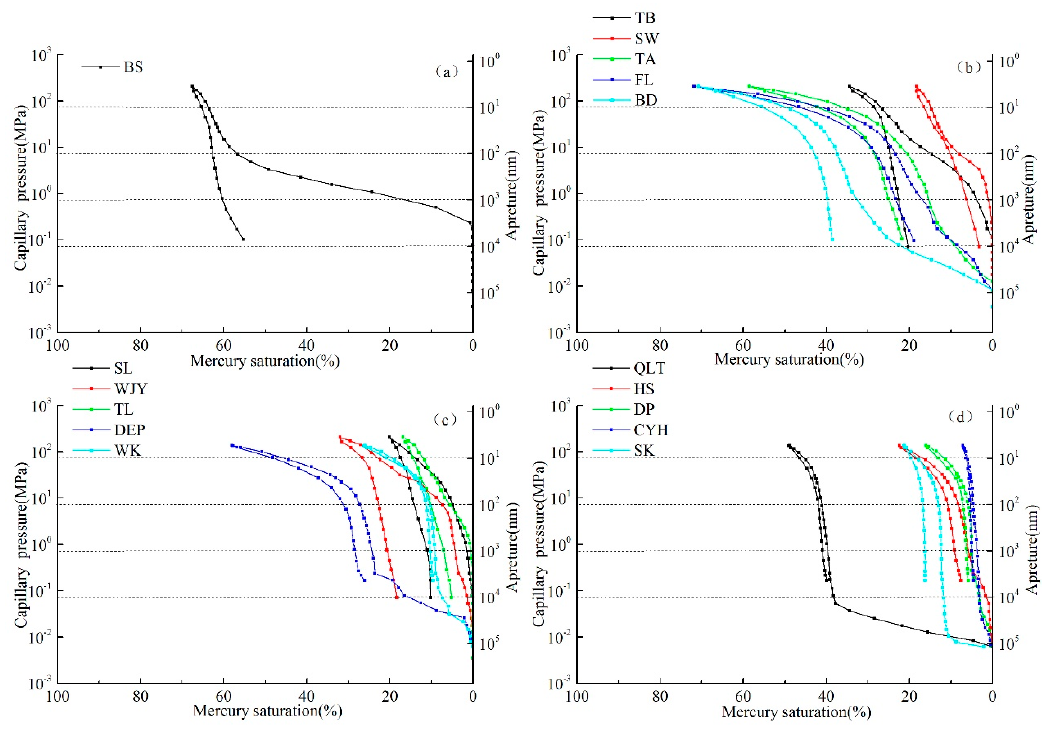
Figure 1. Type of mercury intrusion curve of coal sample (a:type I, b: type II, c: Type III, d: Type IV ) .